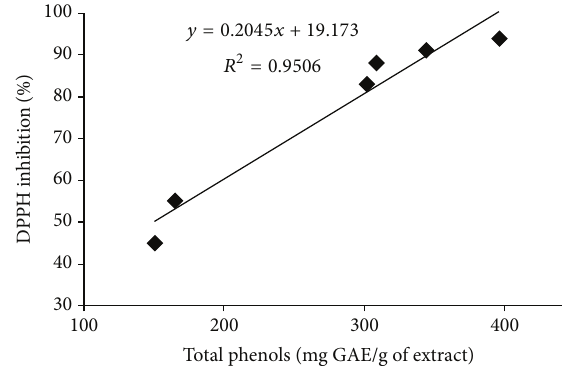
Figure 4: Correlation between total phenols and DPPH scavenging activity of bark extracts of Loranthus pulverulentus .